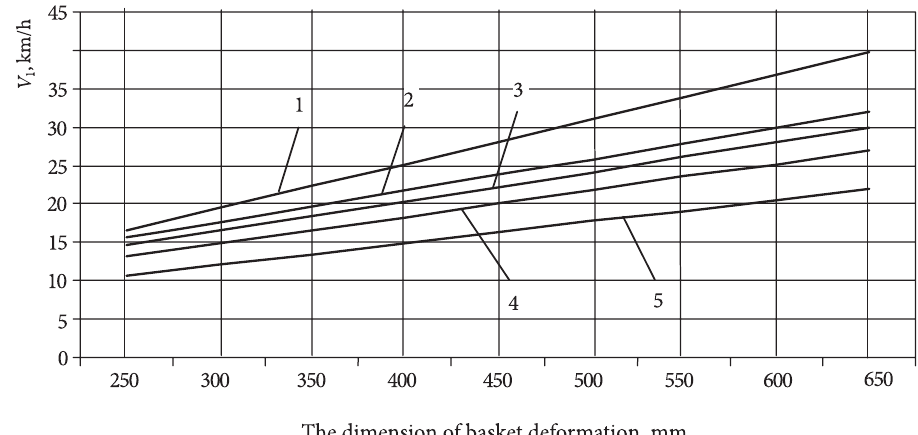
Fig. 7. Dependence of car speed before hit and car deformation aft er hit C and car stiff ness in case of central collision with a tree, i when coeffi cients of stiff ness are the following: 1 – A = 65.5 kN/m, B = 500 kN/m 2 ; 2 – A = 63.8 kN/m, B = 400 kN/m 2 ; 3 – A = 95.2 kN/m, B = 760 kN/m 2 ; 4 – A = 74.5 kN/m, B = 480 kN/m 2 ; 5 – A = 63.9 kN/m, B = 358 kN/m 2